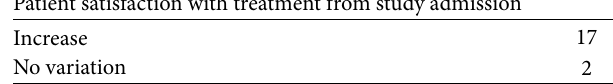
Table 10: Patient satisfaction